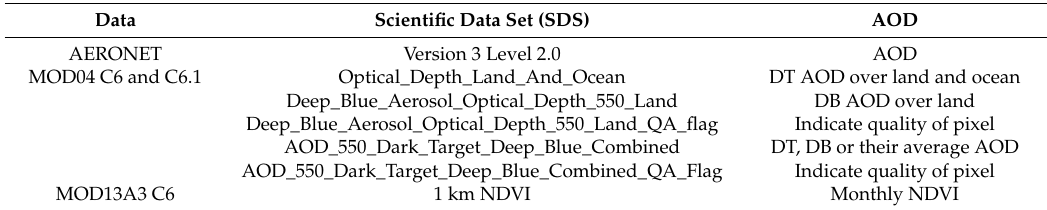
Table 1. Summary of the data sets